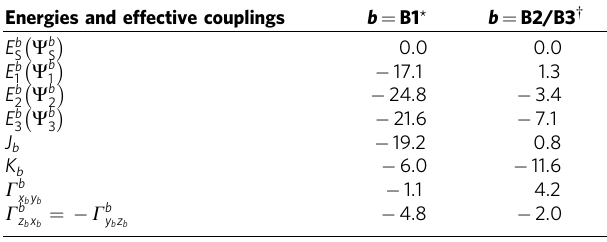
Table 1 | Magnetic spectra of two adjacent Ir 4 þ sites and effective exchange interaction parameters in Li 2 IrO 3 .